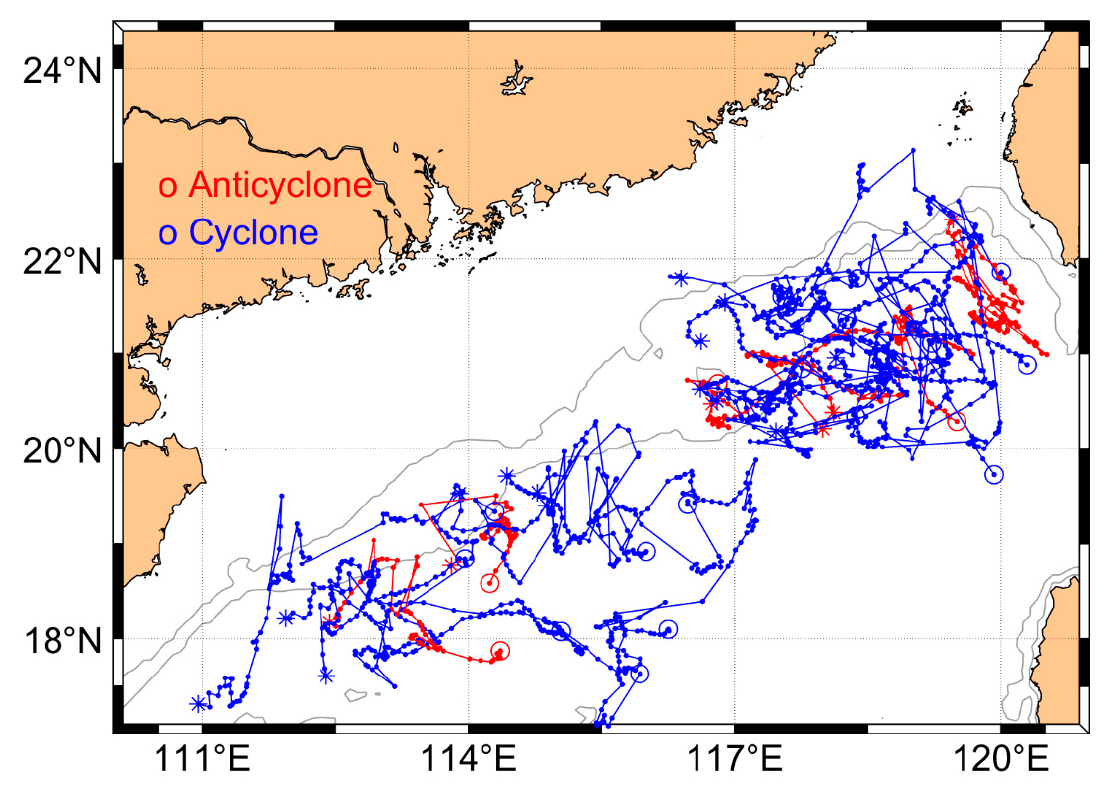
Figure 8. The pathways of the local wandering mesoscale eddies. The red curves with points are anticyclonic eddies. The blue curves with points are cyclonic eddies. The circles indicate generation and the asterisks indicate corruption.